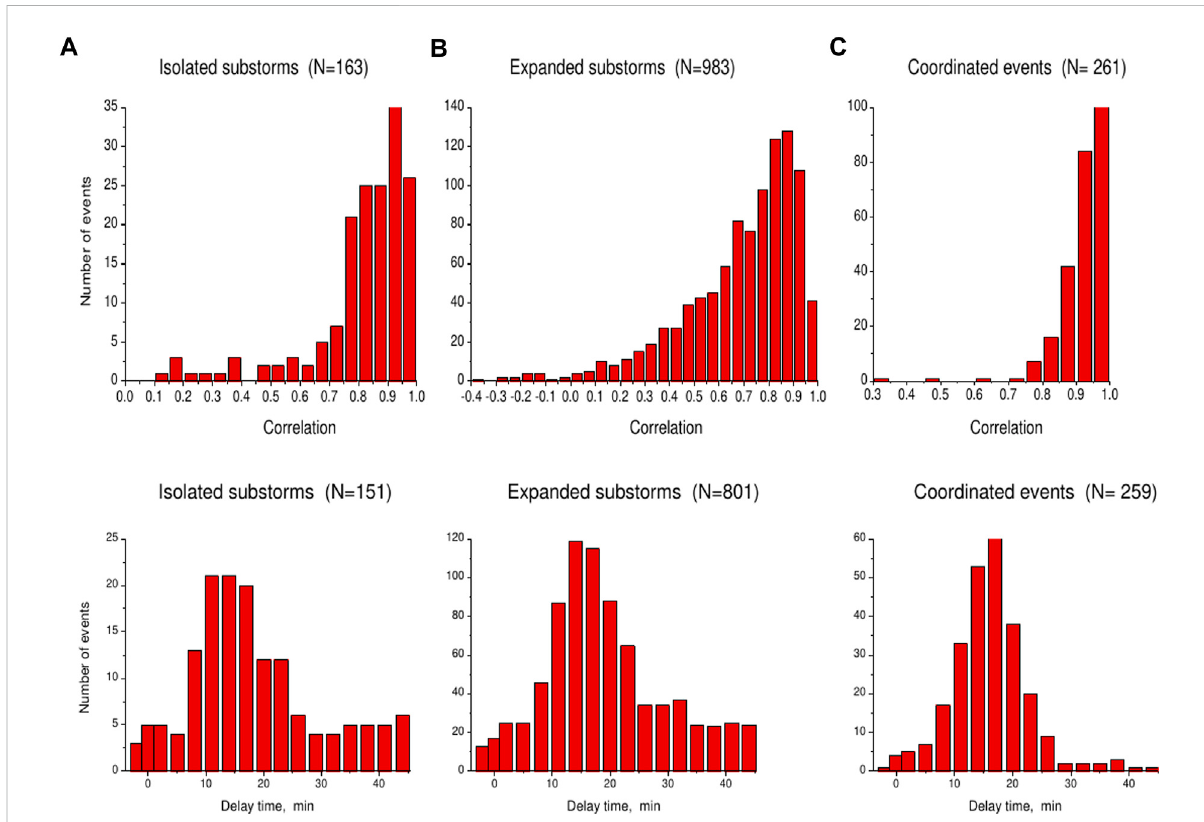
FIGURE 7 Histograms demonstrating values of correlation between the E KL fi eld and PC index (upper panel) and delay time in response of PC index to E KL alterations (lower panel) for events with isolated (A) , expanded (B) and coordinated (C) substorms (Troshichev and Sormakov,